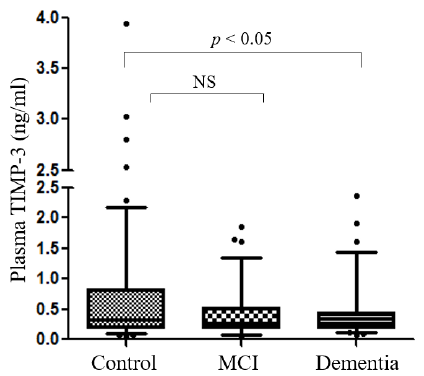
Figure 2. Relative TIMP-3 mRNA levels in human iPSC-derived neuronal cells from an AD patient ( n = 3) and a control ( n = 3). Results are expressed as mean ± SD; statistical significance is indicated by p < 0.05. AD , Alzheimer’s Disease ; SD, Standard deviation.